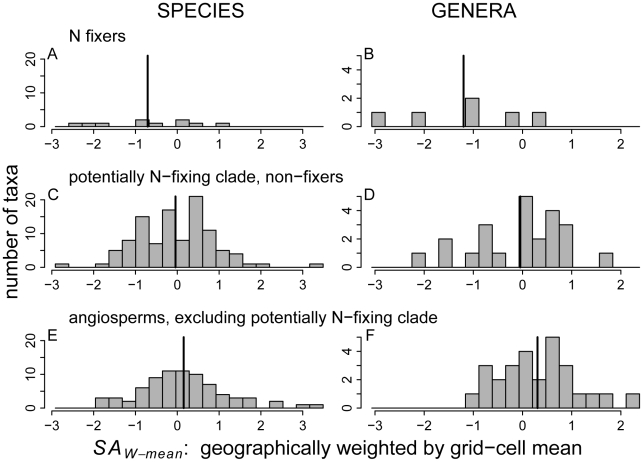
Histograms of the geographically weighted stand age index, SAW-mean.Panels are defined as in Fig. 4. SAW-mean accounts for geographical variation in mean stand age (Fig. S3), and is expressed as the number of standard deviations from the overall angiosperm mean (see Methods for details).